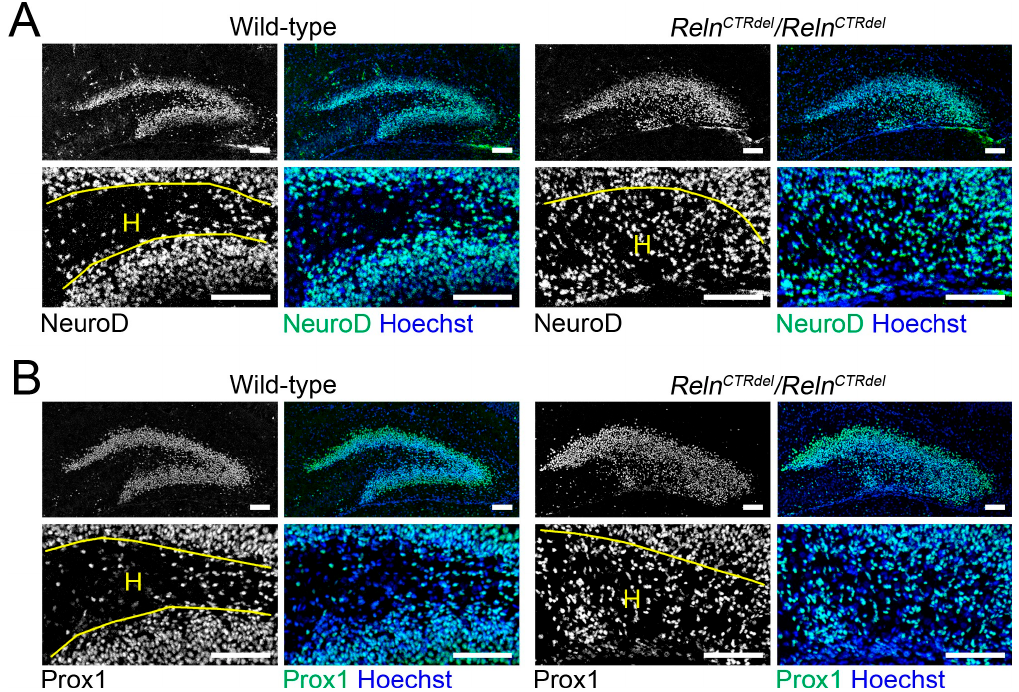
Figure 4. Abnormal distribution of the granule neurons. Granule neuron precursor markers (gray or green), NeuroD ( A ) and Prox1 ( B ), staining indicate the presence of abnormal progenitor population in the hilus (H) of Reln CTRdel at P7 ( n = 2 each). Nuclei were stained using Hoechst (blue). Enlarged images are shown in lower panels. Scale bars, 100 µm.